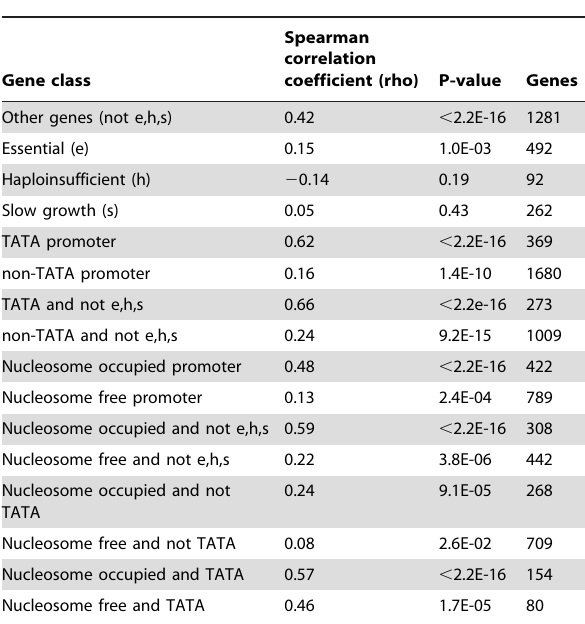
Table 1. Coupling between expression noise and expression plasticity for different gene classes in